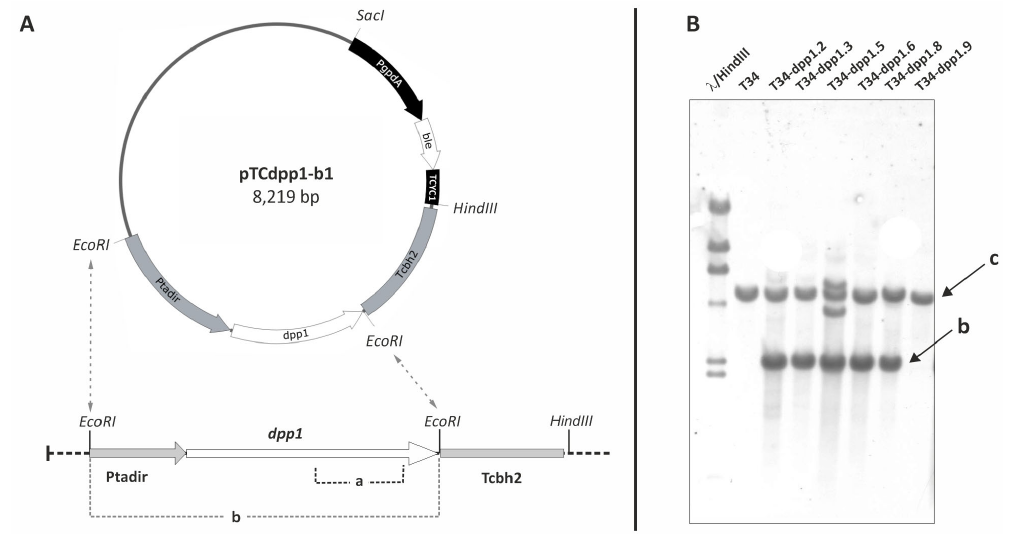
Figure 2. ( A ) Schematic representation of pTCdpp1 ‐ b1. PgpdA, promoter of the Aspergillus nidulans gpdA gene; ble , phleomycin resistance gene from Streptoalloteichus hindustanus ; TCYC1, transcriptional terminator of the Saccharomyces cerevisiae cytochrome C oxidase gene; dpp1 , T. harzianum dpp1 gene. Ptadir, promoter of the T. harzianum tss1 gene, and Tcbh2, transcriptional terminator of the T. reesei cellobiohydrolase 2 encoding gene. ( B ) Southern blot analysis of genomic DNAs from T34 (control) and six transformants with plasmid pTCdpp1 ‐ b1, digested with Eco RI, and hybridized with the 622 bp probe (a) indicated in panel A. Note that in T34 and T34 ‐ dpp1.9 (included as a negative control in the Southern), we only observed the wild ‐ type 4.910 bp band (c), corresponding to the endogenous copy of the dpp1 gene. (b) 2,341 bp Eco RI fragment expected for the dpp1 ‐ overexpression transformants in the southern experiments.